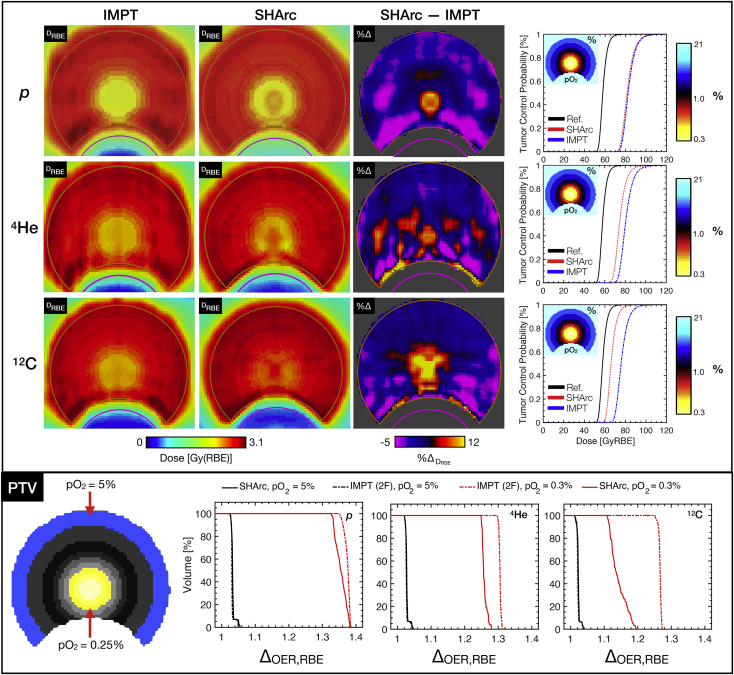
Assessing radio-resistance induced by tumor hypoxia (planning target volume [PTV]) for particle therapy with p,4He, and 12C ions. DRBE maps for spot-scanning hadron arc (SHArc) therapy, intensity modulated particle therapy (IMPT), and subtractions given in terms of percent difference from the prescription dose for case B applying the phenomenological hypoxia reduction factor (HRF) model. pO2 maps are presented alongside tumor control probability (TCP) calculations for SHArc and IMPT deliveries under set conditions of tumor hypoxia compared with reference normoxic conditions (Ref.). ΔOER,RBE plots are provided (bottom) for IMPT-2F versus SHArc plans for the outer PTV ring (pO2 = 5%) and inner PTV core (pO2 = 0.25%) for p,4He, and 12C.